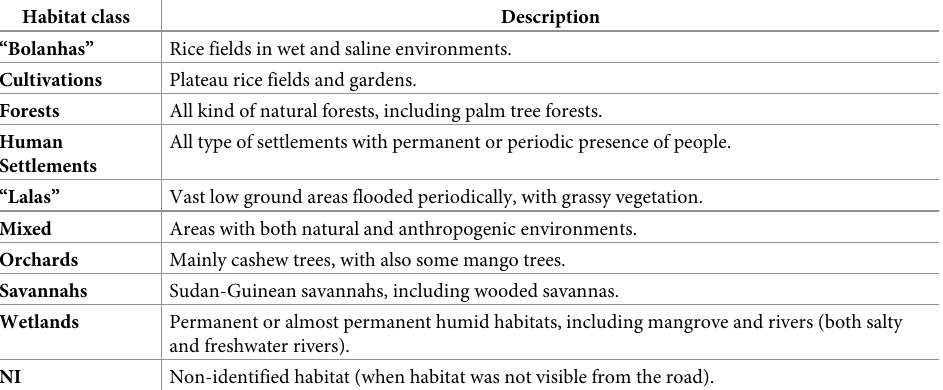
Table 1. Habitat classes created for the analysis of the distribution of Hooded and Gyps spp . vultures over habitats. Habitat